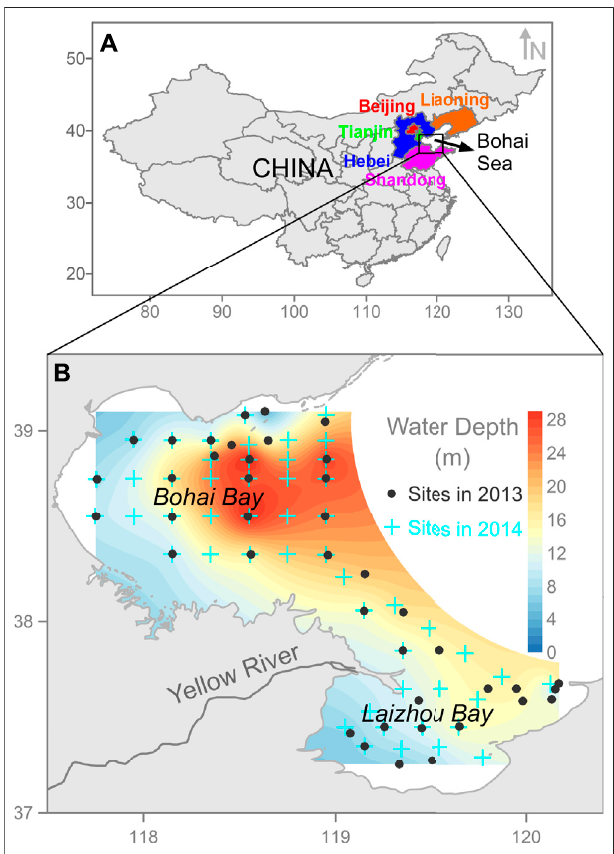
FIGURE 1 | Map of study area illustrating deployed sampling sites with water depth. Note: Details for sampling sites in 2014 is referred to Supplementary Table S1 and Fang et al.